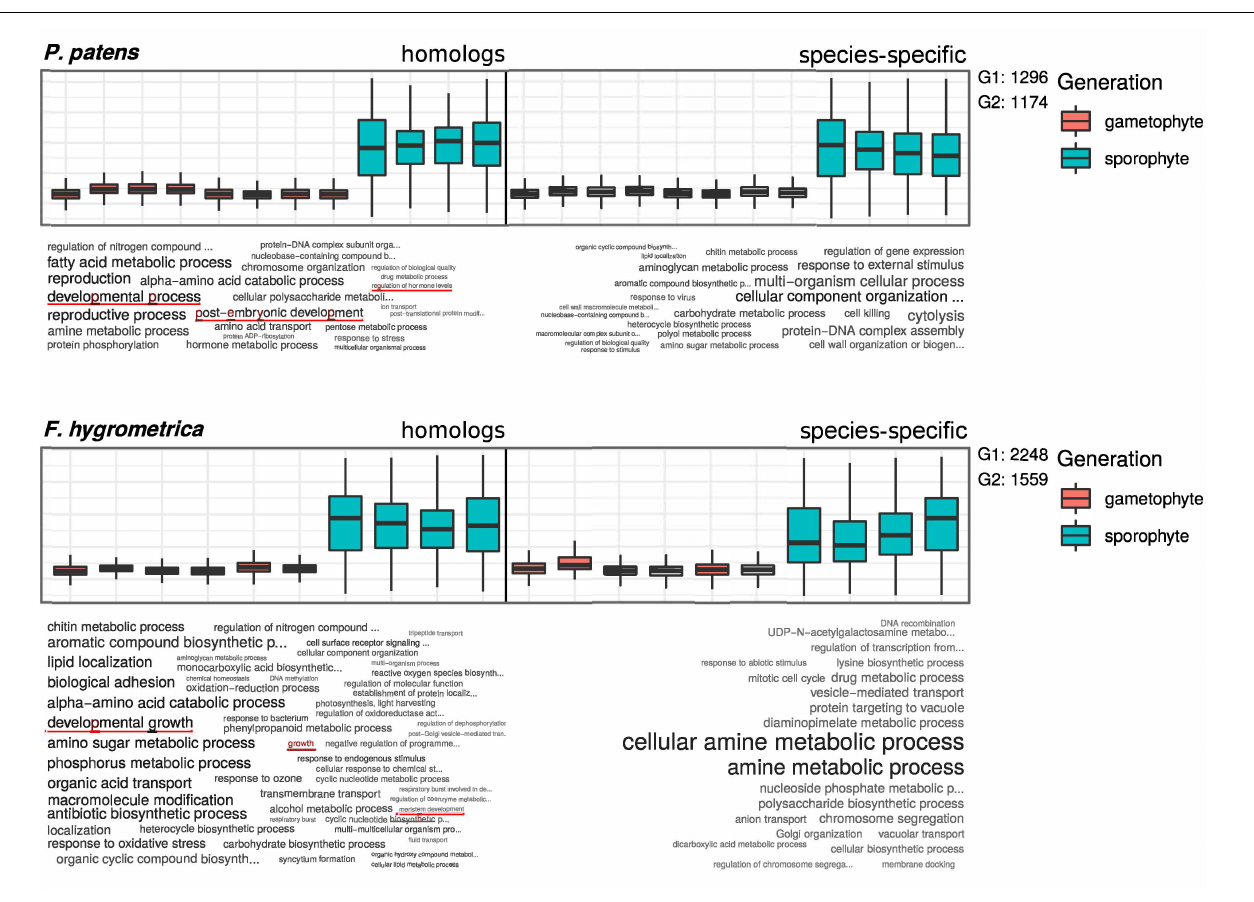
FIGURE 4 | GO term enrichment analysis of preferentially sporophyte expressed genes in Physcomitrium patens and Funaria hygrometrica. Upper panels show standardized expression values of the respective subset of genes. Homologous genes are shown on the left side and species-specific genes on the right side of the plots. Lower panels show a visualization of enriched GO terms in the respective subsets, word size is correlated with the significance value obtained from the enrichment analysis. G1 and G2 denote the number of genes in the subsets of homologous (G1) and species-specific (G2) genes, used in the enrichment analysis. GO terms potentially connected to differential sporophyte development in the two species are underlined (see red